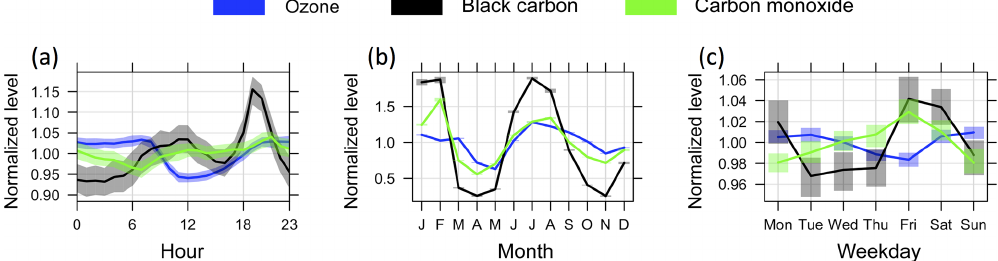
Figure 4. Normalized temporal variations in O 3 mixing ratios, CO mixing ratios, and BC concentrations by (a) hour (diurnal), (b) month, and (c) day of the week. Shaded areas are 95% confidence